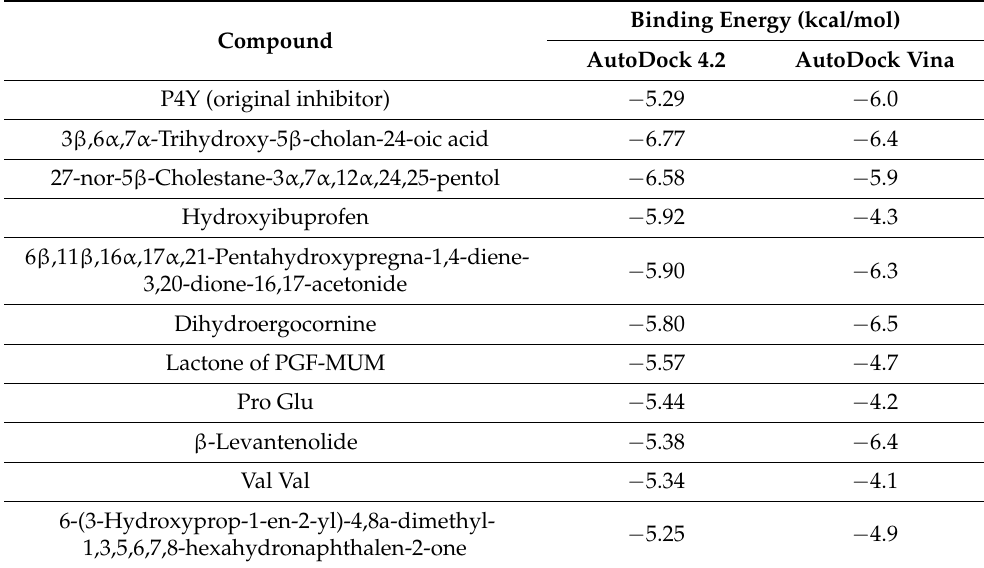
Table 4. Top 10 molecular docking results of CA-identified compounds at the RNase H active site of HIV-1